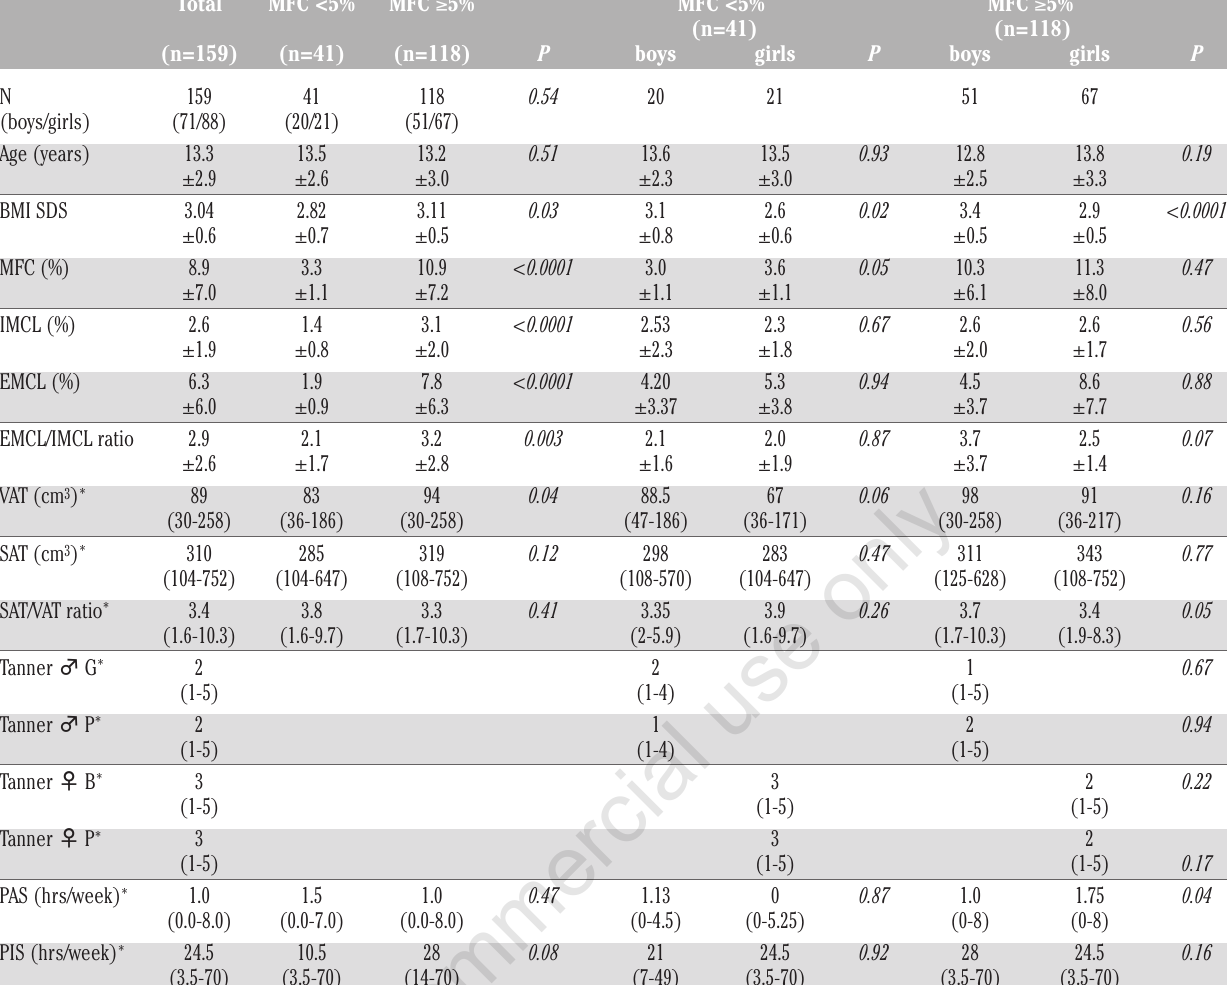
Table 1. Baseline characteristics of all 159 obese children and youths with a muscle fat content <5% and ≥ 5%, respectively.